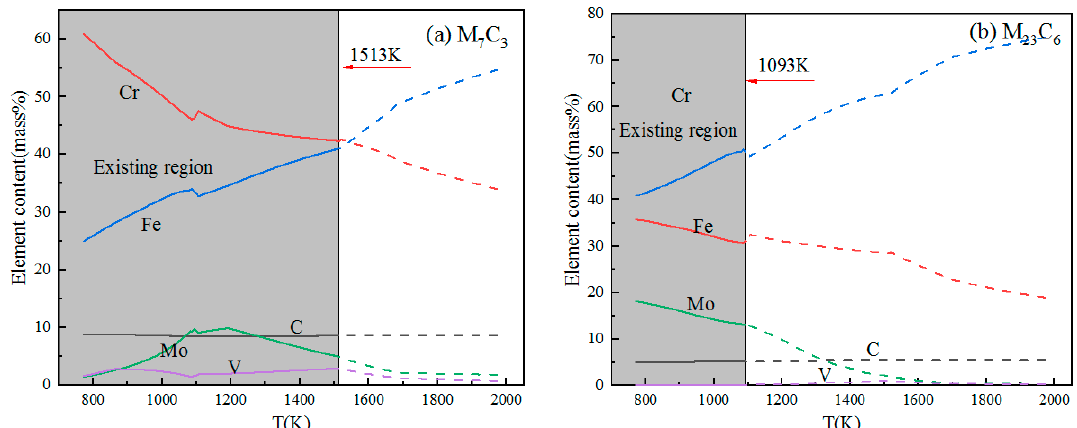
Figure 3. Changes in element contents of M 7 C 3 -type and M 23 C 6 -type carbide in high-carbon 8 mass% Cr tool steel as a function of temperature: ( a ) M 7 C 3 -type carbide; ( b ) M 23 C 6 -type carbide.